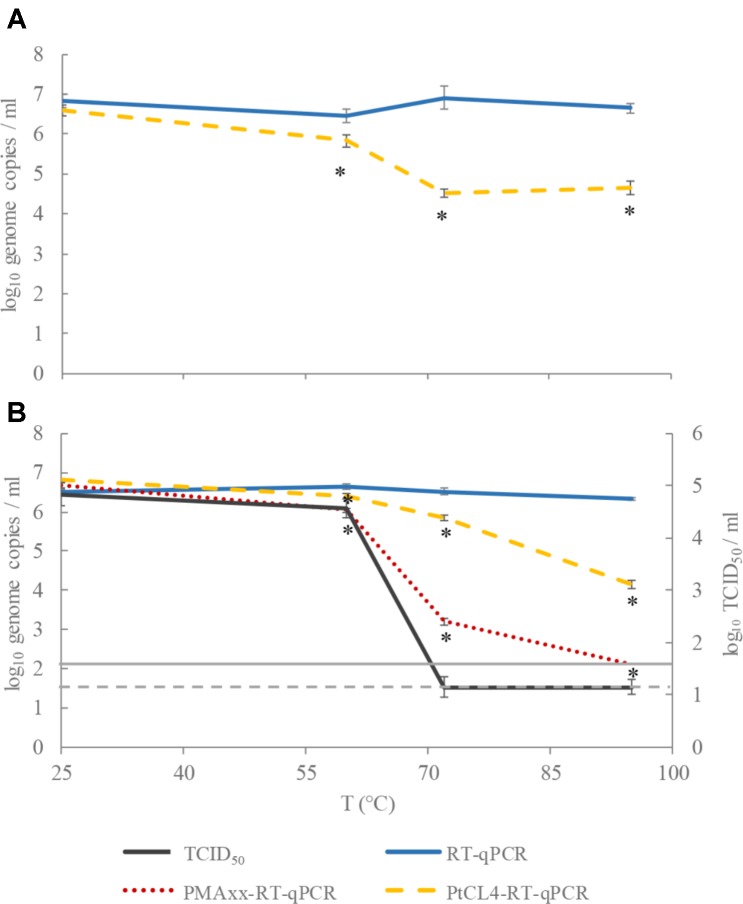
Performance of tissue culture infectious dose (TCID50), RT-qPCR, PMAxx-RT-qPCR, and PtCl4-RT-qPCR to discriminate between infectious and heat-treated HEV (A) and HAV (B) at 60, 72, and 95°C for 15 min. Asterisks (∗) denote significant differences among viability treated samples (PMAxx or PtCl4) and the control (RT-qPCR) for each temperature (p < 0.05). Dashed and continuous gray lines represent the limit of quantification of HAV by TCID50 and RT-qPCR, respectively.